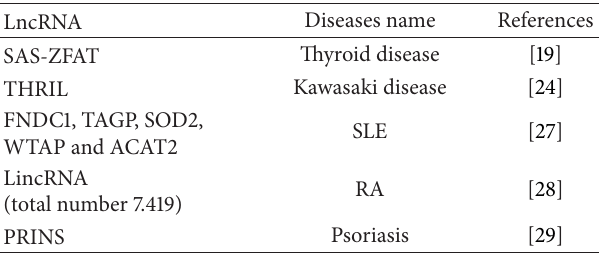
Table 2: List of LncRNA studies, associated with autoimmune